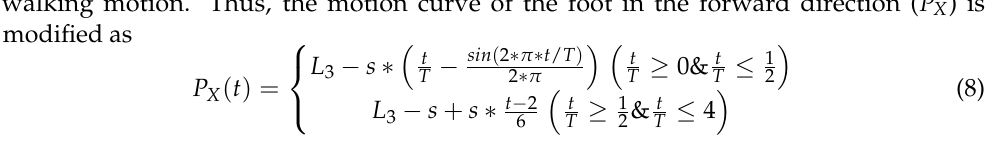
7 of 14 Figure 5. Gait planning: ( a ) four steps of the gait and ( b ) illustration of variations in the trunk end. During straight walking, the velocity of the spine is maintained as constant. The velocity of the front spine consists of two components, i.e., the swinging and the forward velocity of the spine. Therefore, the movement of each leg must be calculated separately. The left hind leg moves forward when the spine bends to the right . Assuming that the position of the entire spine remains unchanged, the wobble phase of the left hind foot can be regarded as the utilized non-impact motion, and the support phase can be a forward walking motion. Thus, the motion curve of the foot in the forward direction ( 𝑃 (cid:3025) ) is mod- ified as